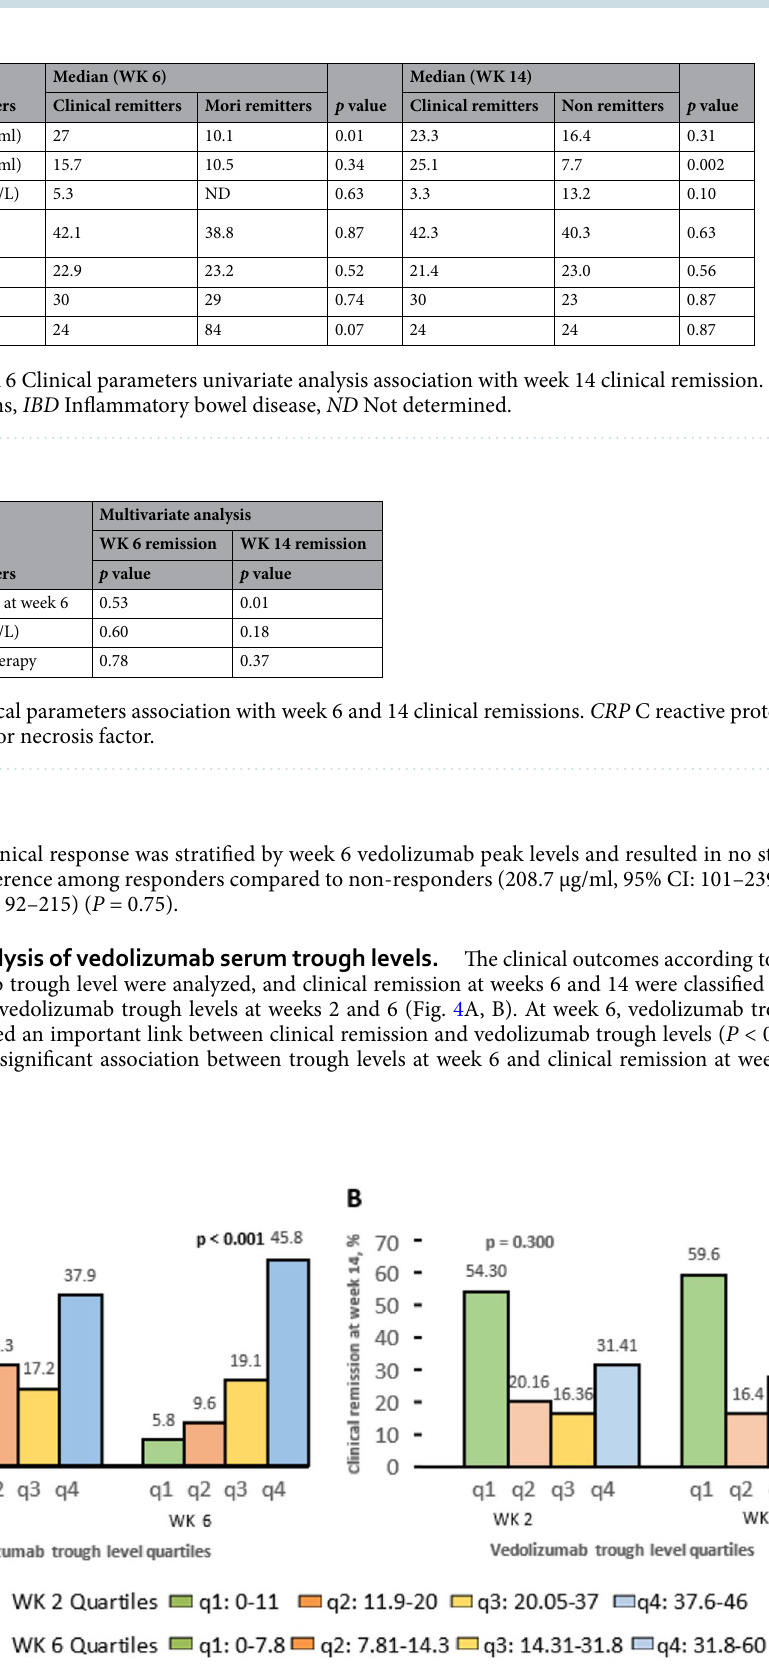
Figure 4. ( A ) Clinical remission was stratified at week 6 based on week 2 and week 6 vedolizumab trough level quartiles from the minimum (Q1) to the maximum quartile (Q4 ( B ) Clinical remission at week 14 classified according to vedolizumab trough levels quartiles at week 2 and week 6 from the minimum quartile (Q1) to the maximum quartile (Q4). P value, one way